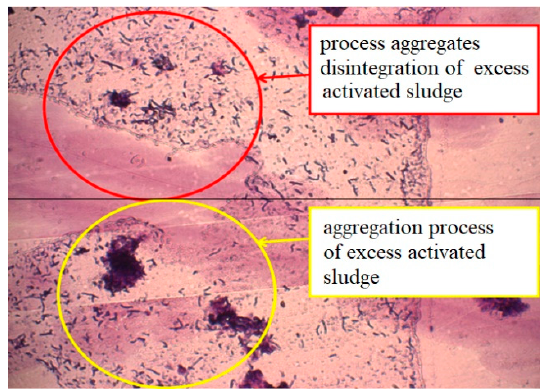
Figure 7. Formation and disintegration of sludge aggregates. Light microscopy. Gram staining. Magnification ×40.